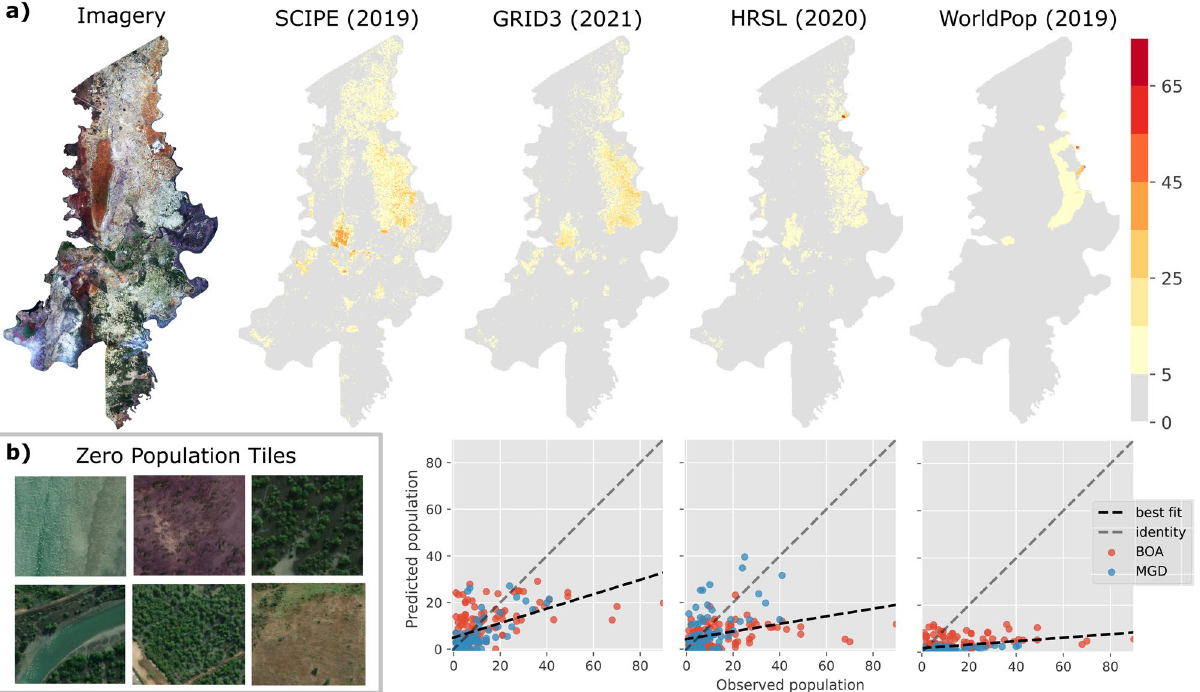
Figure 3. Regional population map comparison and zero population tiles. ( a ) Gridded population count estimates over Boane (top), and comparison against microcensus (bottom). Year indicates target year for estimation where known, otherwise when estimates were published. We do not compare our results on the microcensus as this was our training and validation data. ( b ) Examples of zero population tiles from section “Satellite imagery and